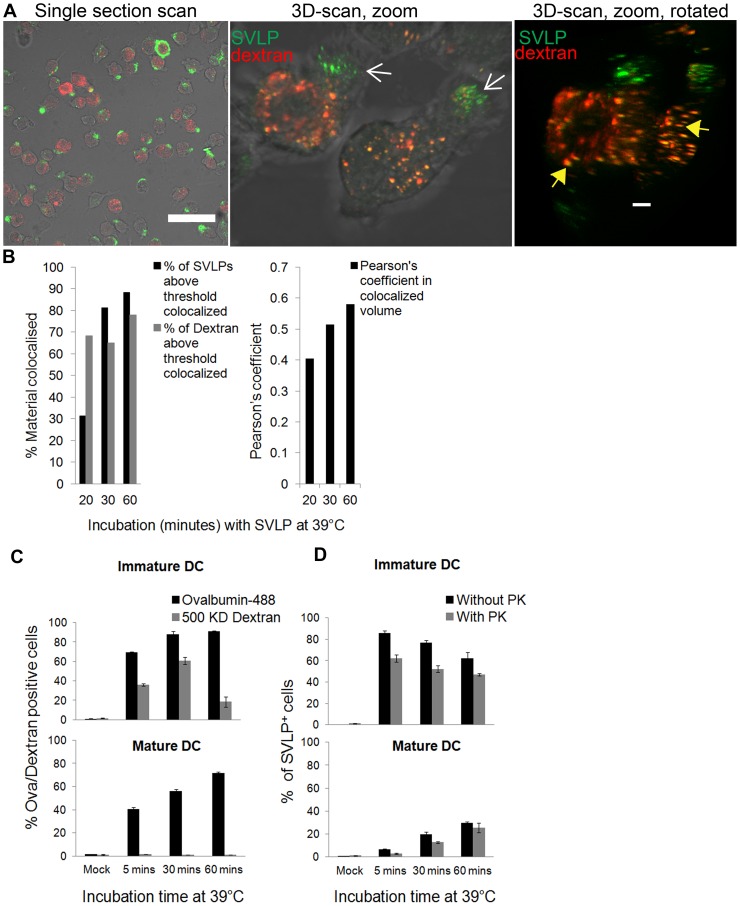
SVLP association with high molecular weight dextran and its uptake by mature or immature DC.(A) DC were incubated with 50 µg/ml high molecular weight dextran for 30 min at 39°C, followed by “on ice” for 30 min. Cells were then treated with 2.5 µg/ml SVLP and incubated for 30 min, then shifted to 39°C for different times. Acquisition was by confocal microscopy; high-resolution stacks were prepared using IMARIS. White arrows: SVLP near the leading edge. Yellow arrows: Dextran+ vesicles in apposition with SVLP-vesicles. Scale bars: 50 µm (top-left), 3 µm (zooms). (B) Algorithms of SVLP co-localisation with dextran. (C) Four-day old DC were treated or not with interferon-α (1000 U/ml) and lipopolysaccharide (10 µg/ml) for 24 hrs to mature. High molecular weight dextran (50 µg/ml) or ovalbumin (10 µg/ml) was added, and incubated for 5, 30 or 60 min at 39°C. The number of positive cells was measured by flow cytometry; each bar represents means of three values and standard deviation. (D) Internalisation of SVLP (1 µg/ml) by the immature and mature DC used in (C). SVLP were added for 30 min on ice, then shifted to 39°C for different times, when the cultures were chilled and treated or not for 30 min with PK on ice. The number of positive cells was measured by flow cytometry; each bar represents means of three values and standard deviation.